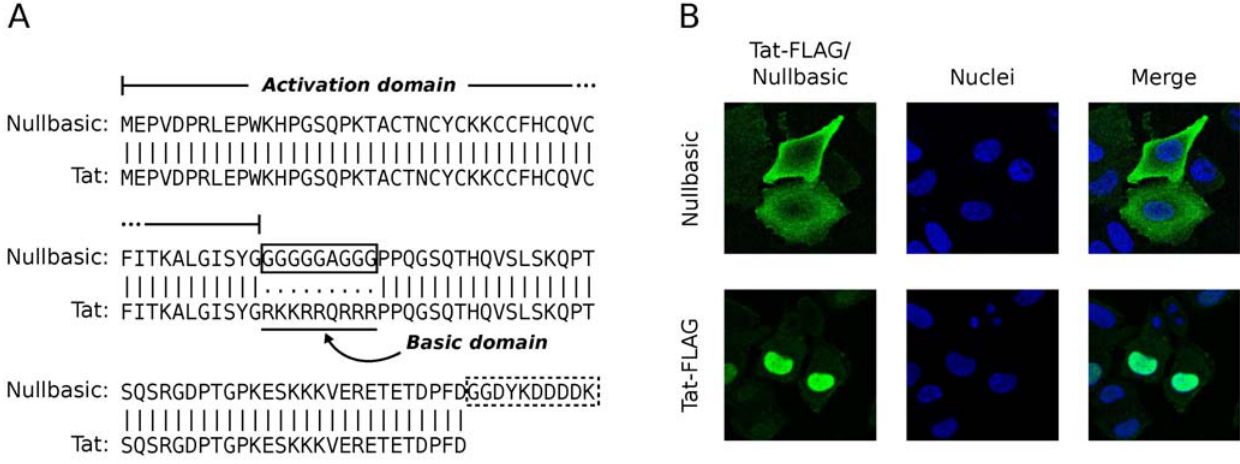
Figure 1. Nullbasic is a HIV-1 Tat mutant that localizes to the cell cytoplasm. ( A ) Amino-acid sequence alignment of Nullbasic (upper rows) against the BH10 clone of Tat (lower rows). Vertical bars indicate amino acid identity and dots indicate engineered substitutions. The solid box highlights the engineered basic domain mutations in Nullbasic, while the dashed box indicates a FLAG epitope tag added to the carboxy terminal. ( B ) HeLa cells expressing Nullbasic (top row) or Tat-FLAG (botton row) were visualized by confocal microscopy using anti-FLAG/FITC antibodies. Nuclei were stained with DAPI. Images are representative of 6 fields per slide from two independent experiments.